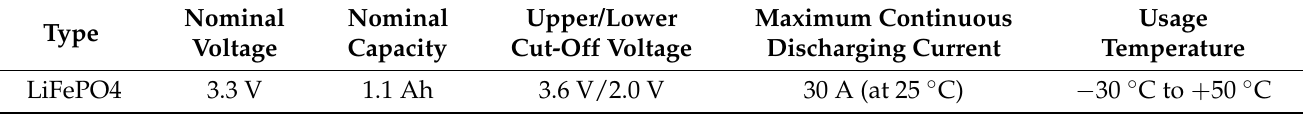
Table 1. A123 Cell Parameters.